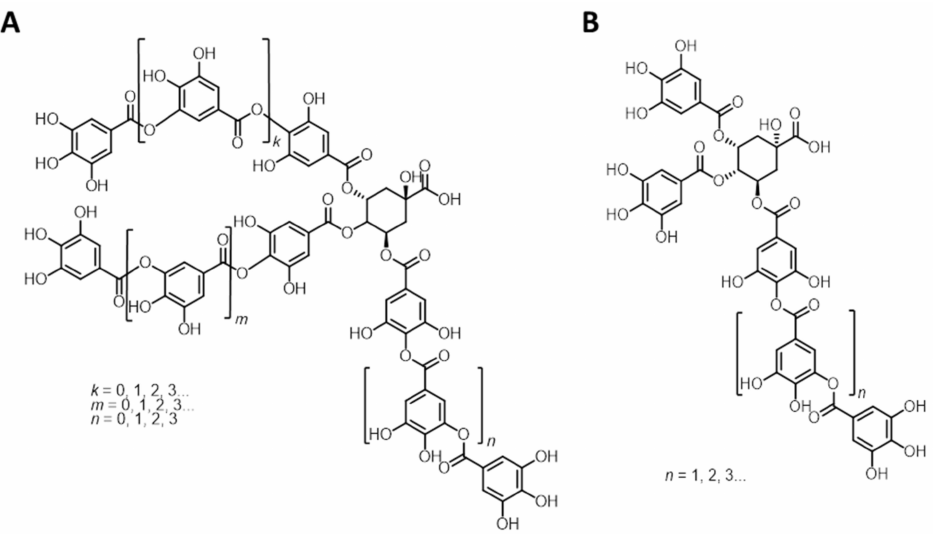
Figure 7. Structural representation delineated on the basis of NMR and MALDI-ToF data of ( A ) Tanal 04 ( Ta-04 ) and ( B ) TARA POLV TIPO A ( Ct